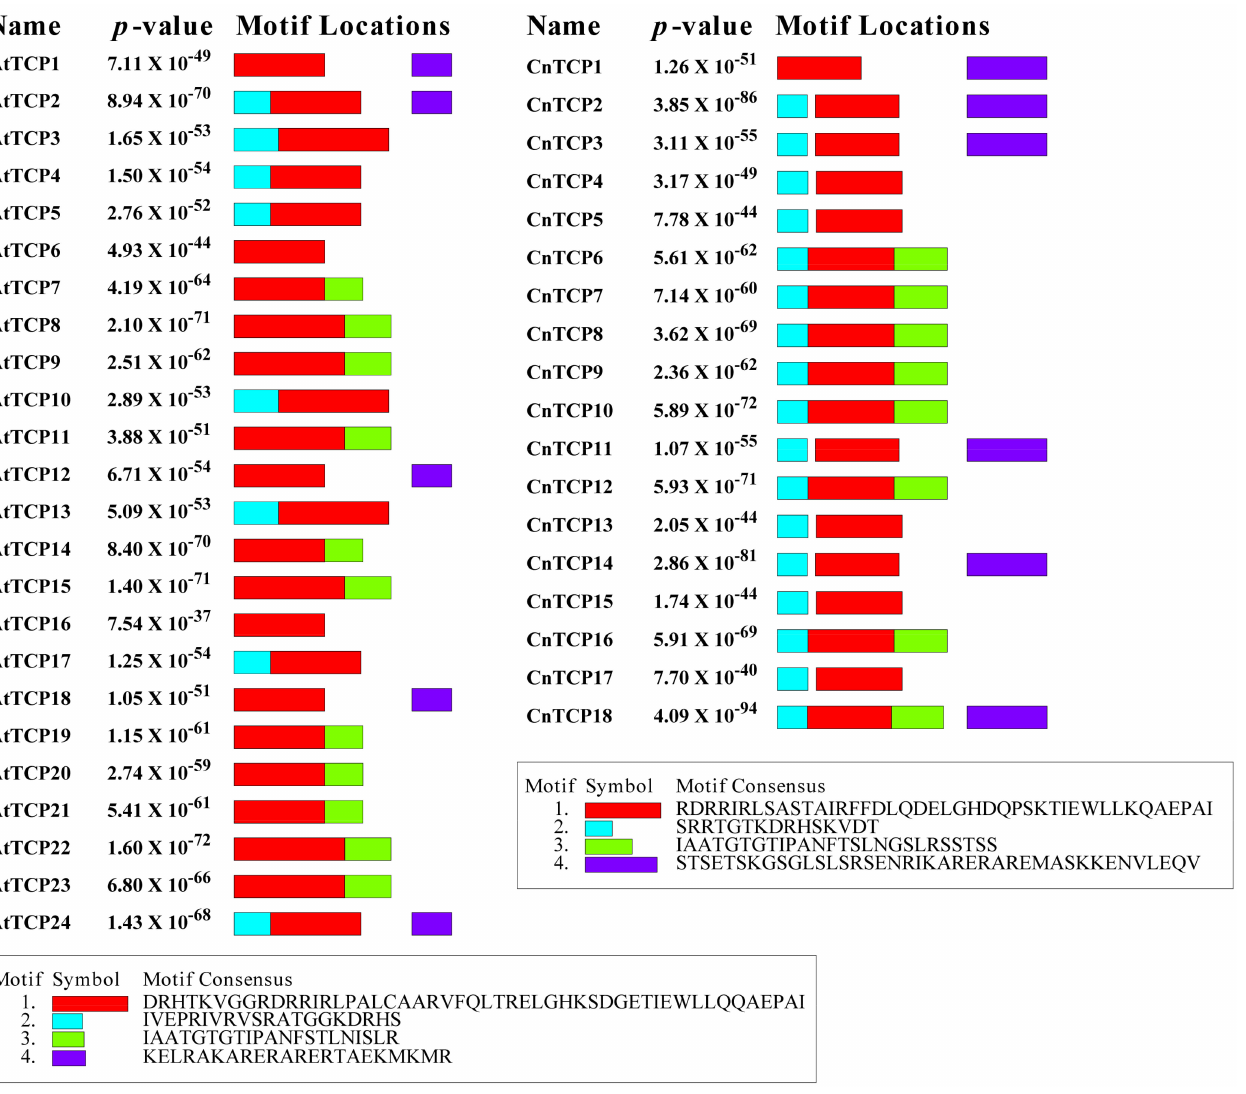
Figure 3. Predicted protein schematic structures of TCPs. The protein structure based on the TCP proteins from Arabidopsis thaliana (left) and Chrysanthemum nankingense (right); other additional domains are as identified by SMART. The bottom box indicates the motif number, symbol, and the motif consensus sequence of the corresponding domain. Actual motif length and order are presented for each